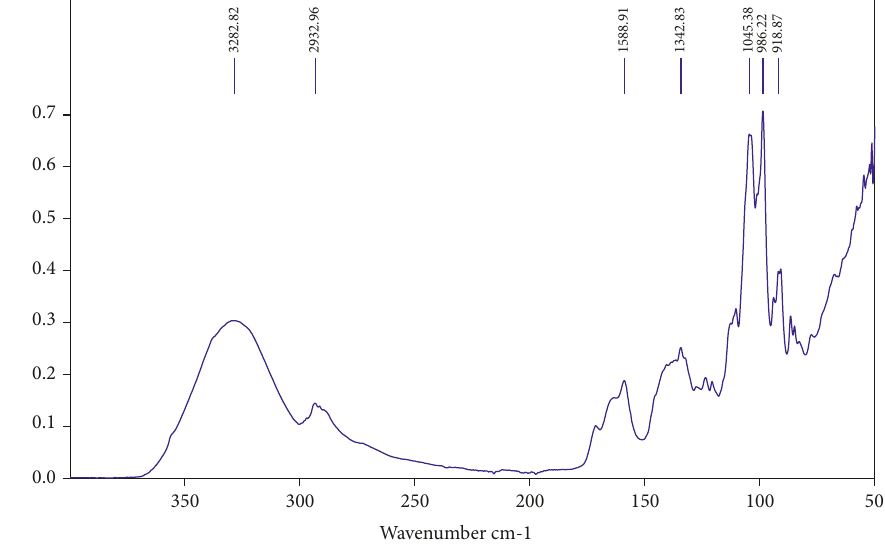
Figure 1: FT-IR spectrum of B. vulgaris peels and pomace